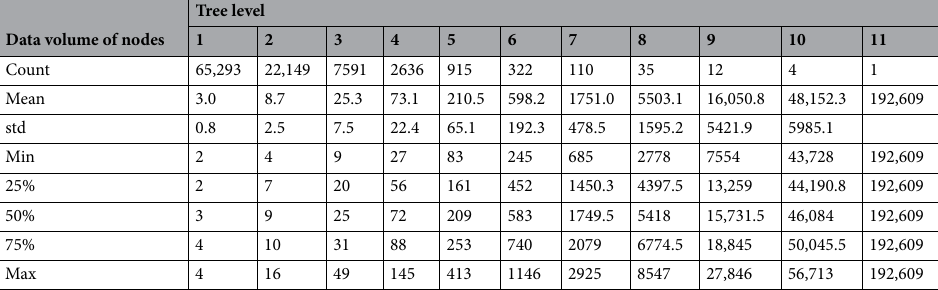
Table 2. The statistics of data volume of node by tree level.